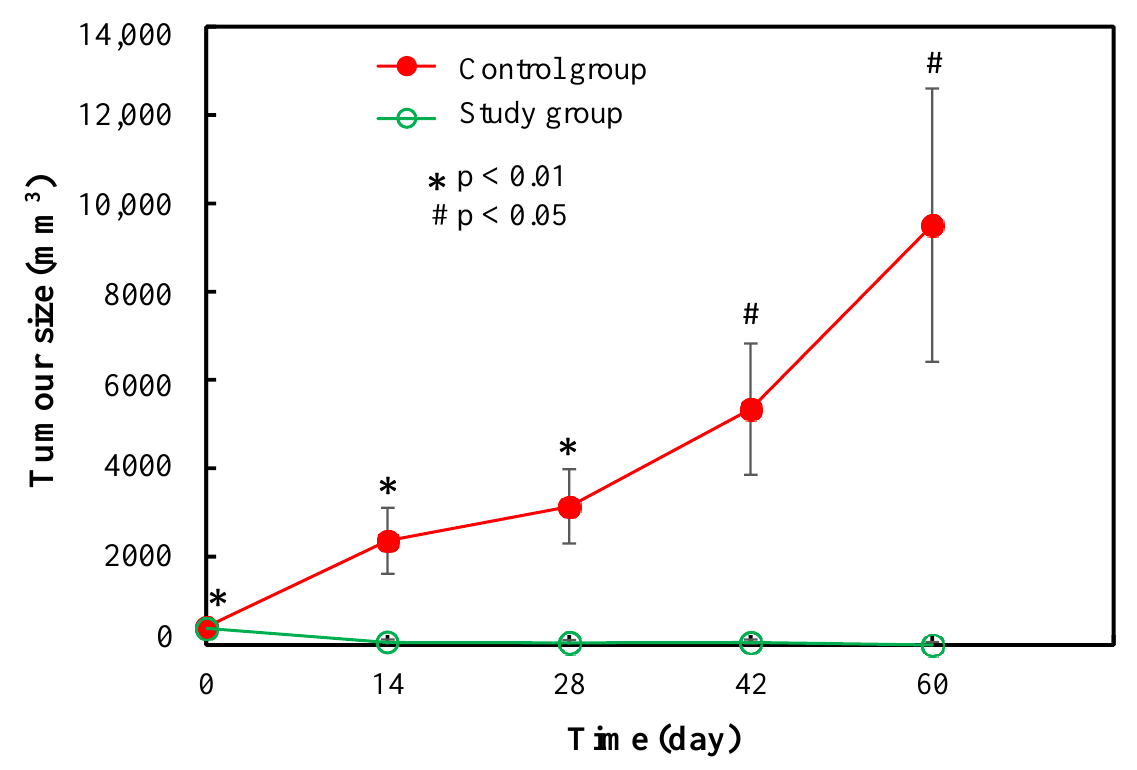
Figure 2. Tumour volume assessment of the effect of [ 153 Sm]Sm 2 O 3 -PS microspheres on the N1-S1 hepatoma cell-induced tumour in SD rats. Tumour volume of the study and control groups were assessed at Day 0, Day 14, Day 28, Day 42, and Day 60 post-injection.